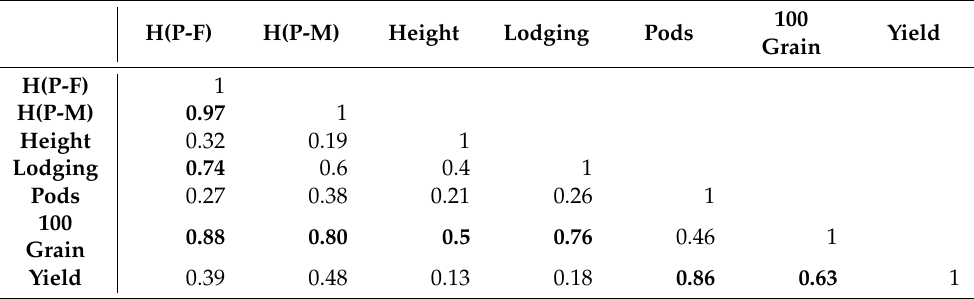
Table 6. Correlations of GDDs for two developmental stages (sowing to flowering, H(P-F) and sowing to maturity, H(P-M)), height, lodging, number of pods per plant, 100-grain weight, and yield (correlation coefficients between 0.5 and 0.7 indicate moderate correlation between variables, while correlation coefficients between 0.2 and 0.49 indicated variables with weak correlation. Numbers are shown in bold when the correlation coefficient was greater or equal to 0.5).